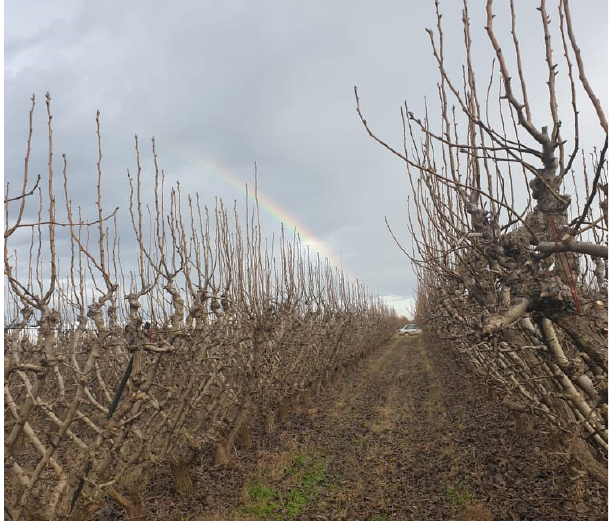
Figure 6. Unpruned tops in a nashi block. Photo credit: Steven Singh, Seeka Australia Pty Ltd.